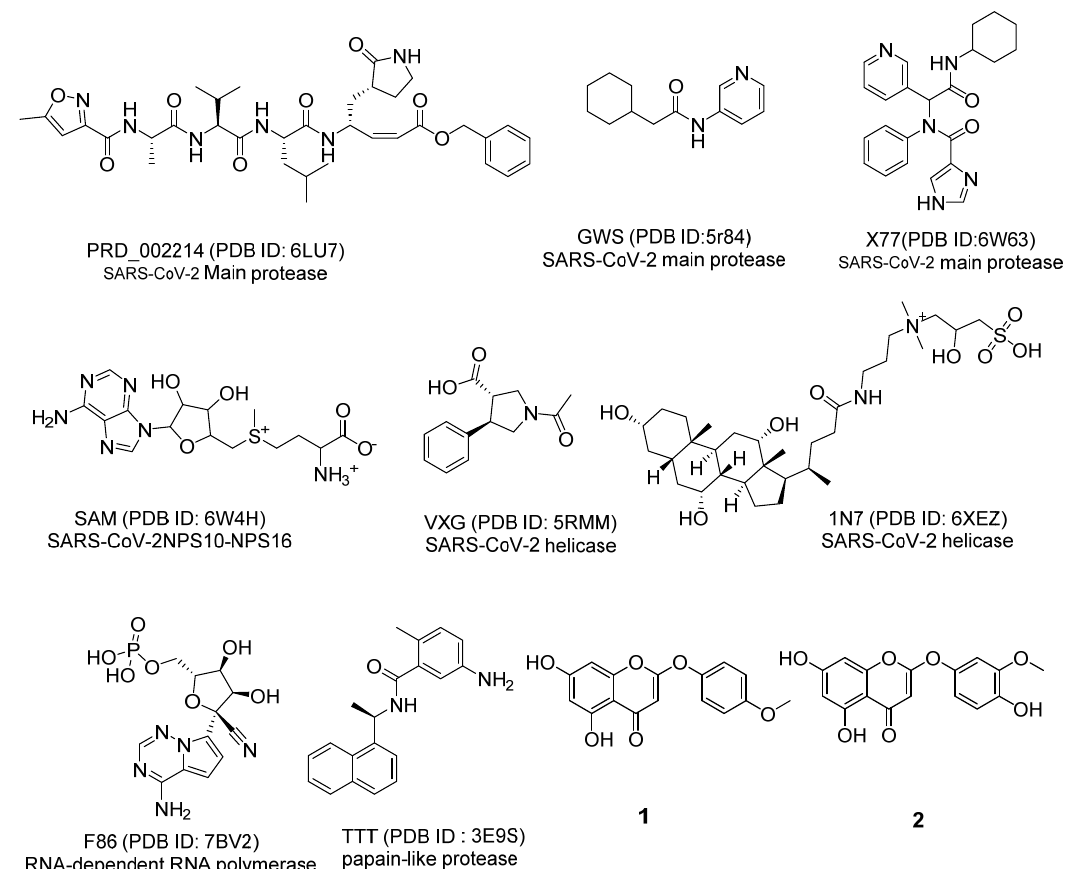
Figure 2. The co-crystallized ligands of coronavirus proteins and compounds 1 and 2. Table 1. Structural properties of compounds 1 , 2 and TTT.